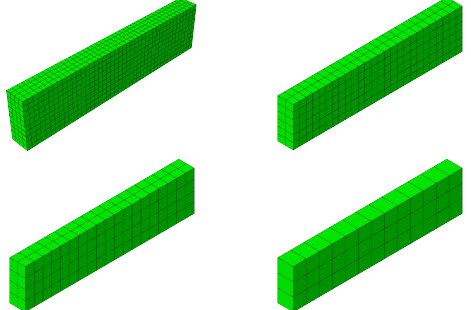
Figure 16. Meshes assumed in case study 2 (CS2).